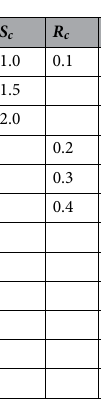
Table 3. Numerically calculated values of Sherwood